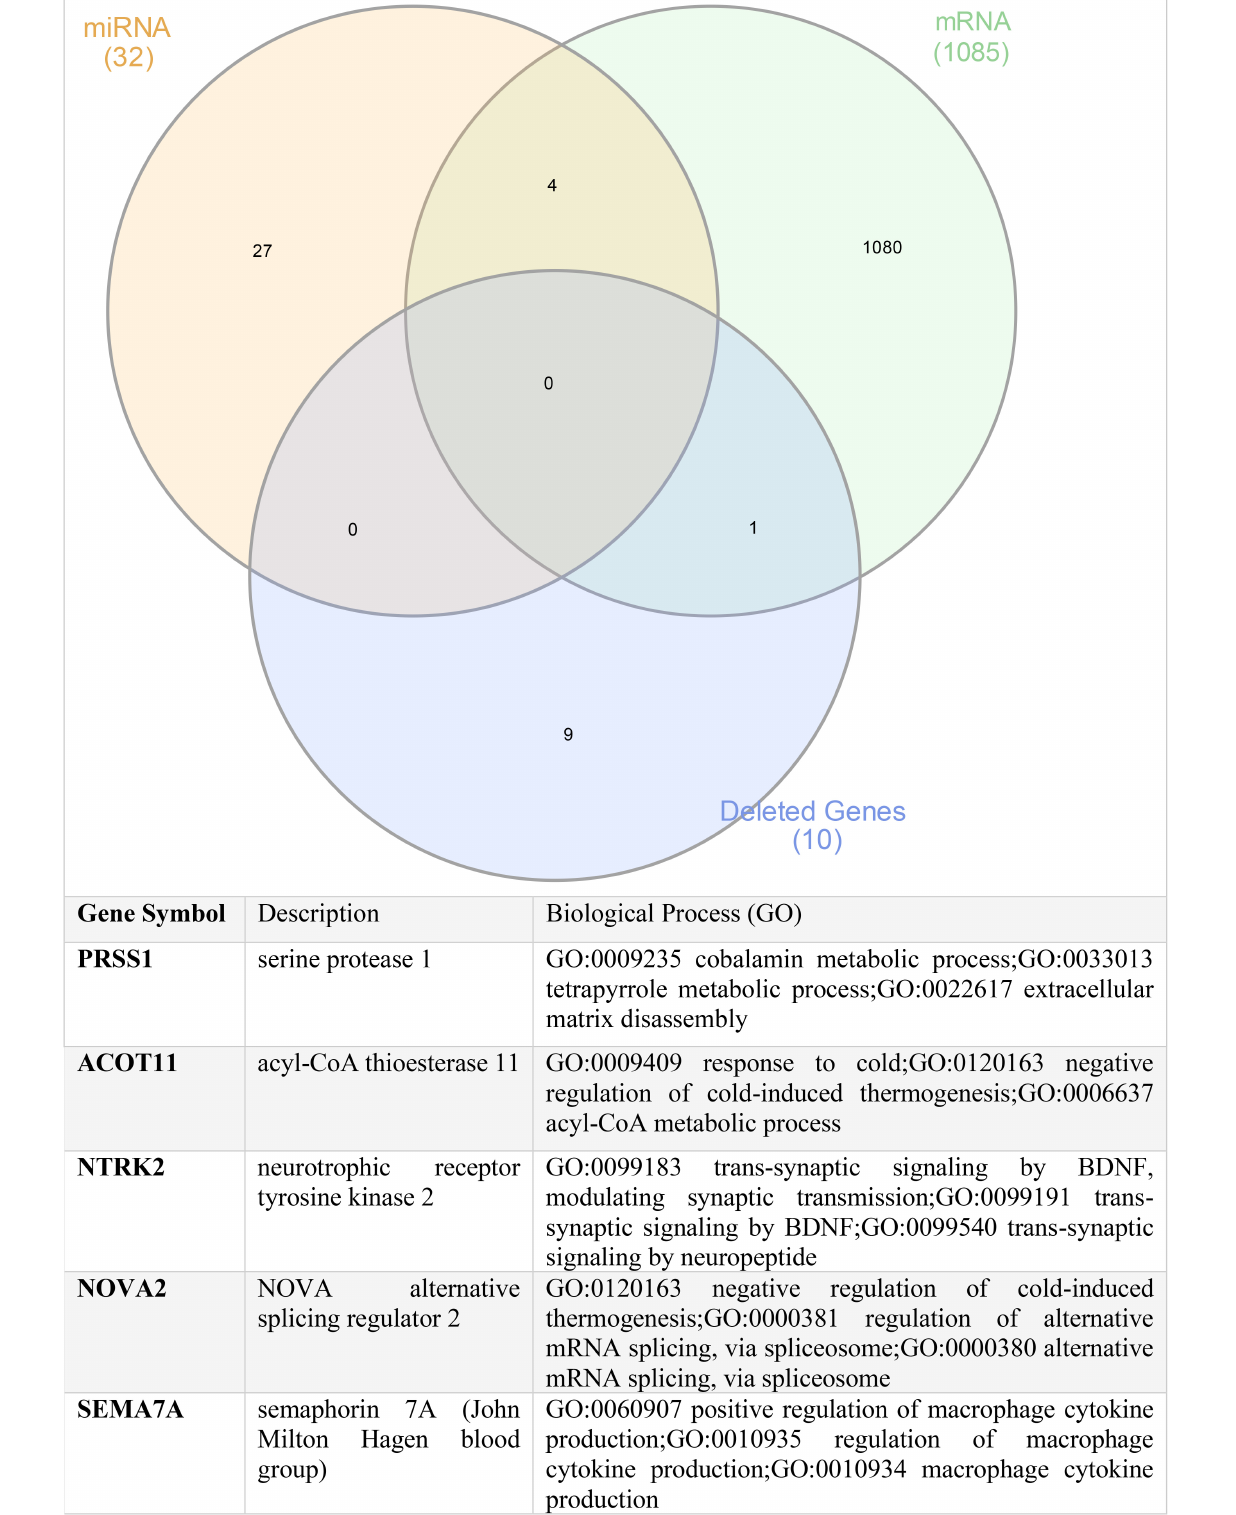
FIGURE 8 | Shared genes between the commonly deleted genes, upregulated mRNA genes, and common targets of the altered miRNA.